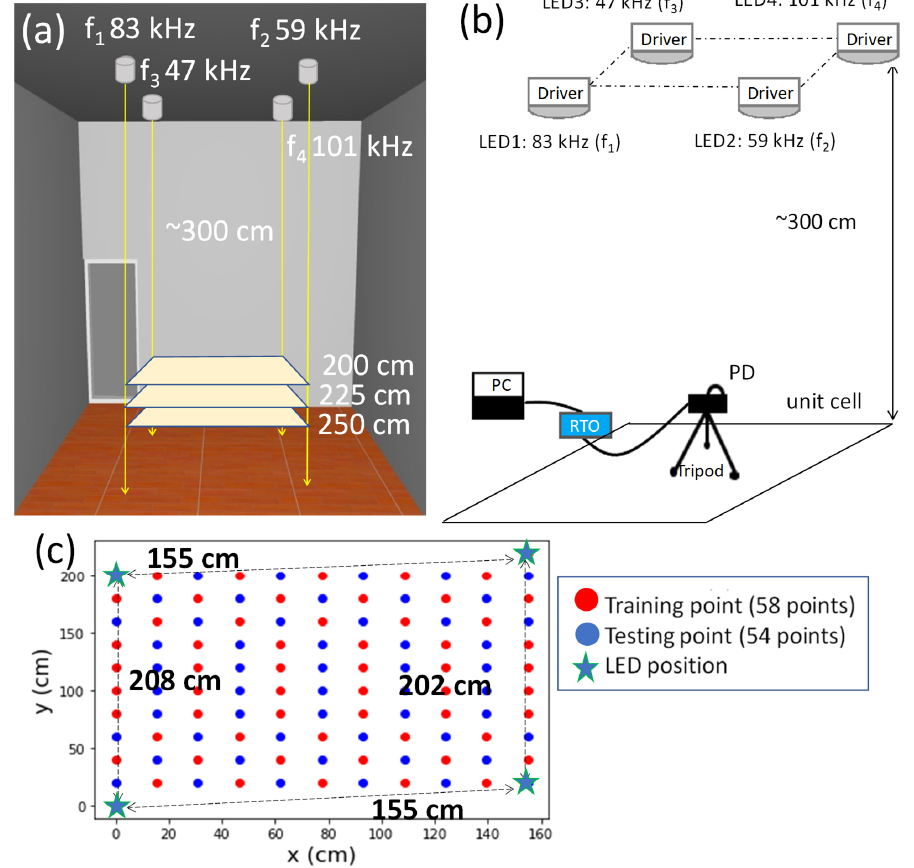
Figure 1. ( a ) Architecture and ( b ) experimental setup of the proposed 3D RSS VLIP system. ( c ) Top-view of the VLIP layer, illustrating the LED lamps, testing, and training locations.